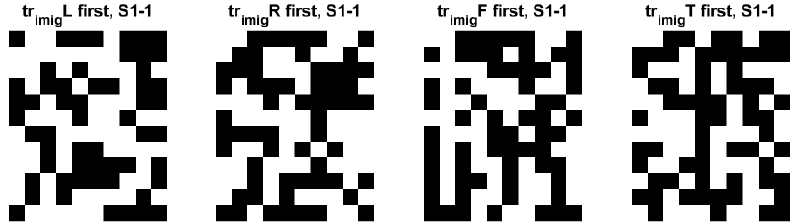
Figure 10. Training QR code realization of subject 1 at trial 1 for 4 classes: left, right, feet, and tongue (12 × 10) in C3D3a_4C.